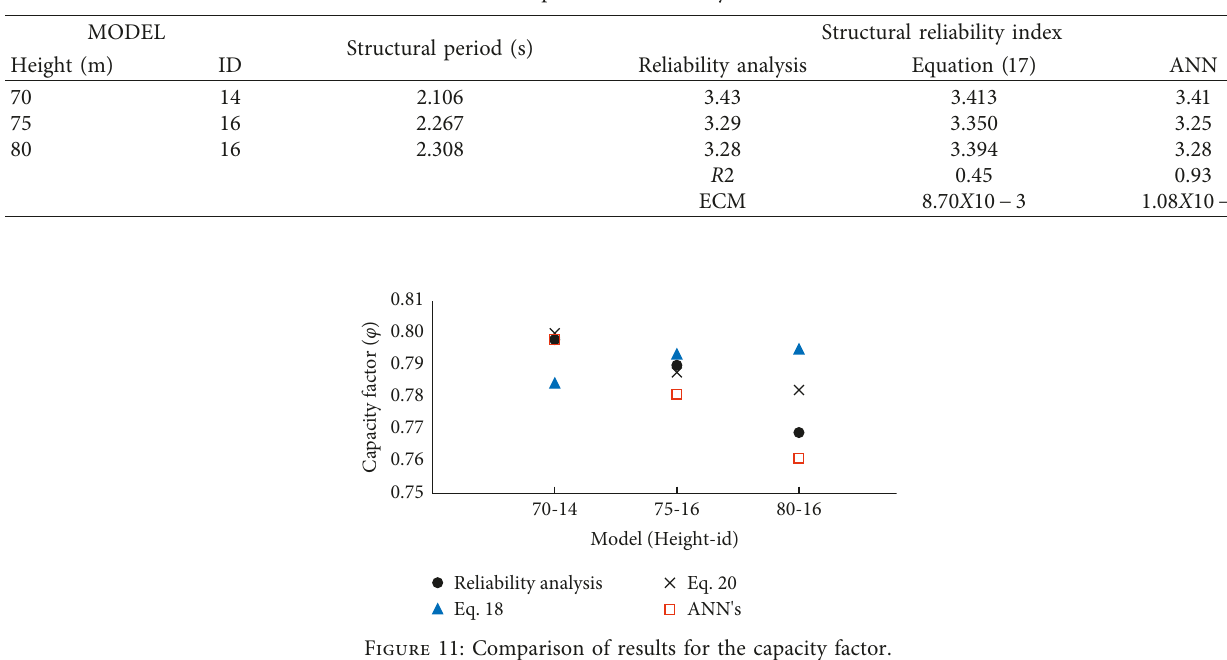
Table 10: Comparison of reliability index results.